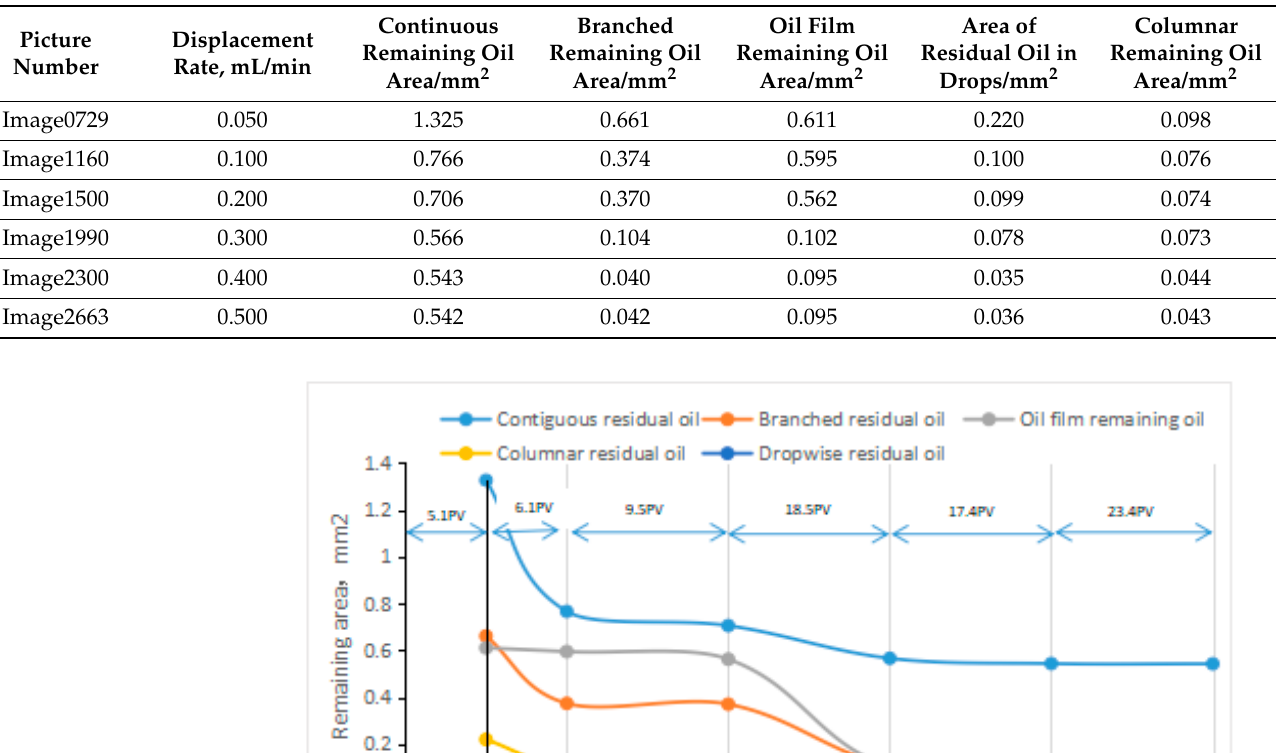
Table 5. Data of remaining oil area after displacement of five types of remaining oil by different water drive rates.